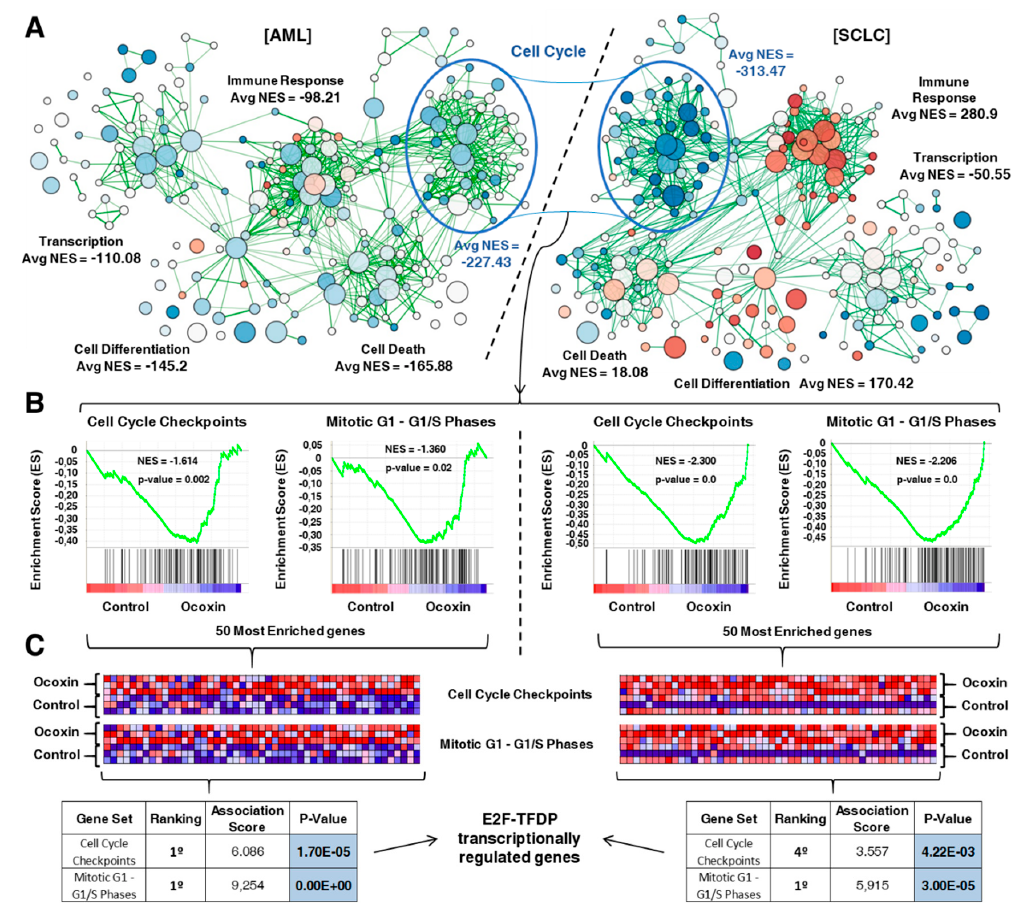
Figure 2. Functional analysis of transcriptomic alterations caused by OOS. ( A ). Gene-set enrichment expression network designed using Cytoscape to compare control and OOS-treated cells in our two experimental models, AML (left) and SCLC (right). Several cellular functions were clearly deregulated by OOS. Cell Cycle had the highest average normalized enrichement score (Avg NES) in both tumor models. ( B ) Enrichment score (ES) profile and location of GeneSet members on the rank-ordered list of the two most deregulated cell cycle GeneSets (“Cell Cycle Checkpoints” and “Mitotic G1-G1/S Phases”) in the AML model (left panels). Both ES profiles behaved very similarly in the SCLC model (right panels). ( C ) Blue-pink diagram of the 50 most OOS-deregulated genes included in “Cell Cycle Checkpoints” and “Mitotic G1-G1/S Phases”. Overexpressed genes are displayed in shades of pink-red, and downregulated genes in shades of blue. PASTAA online tool results are displayed in the table. The highest association score for three of the four pools of genes analyzed correlated the expression of these genes to the E2F